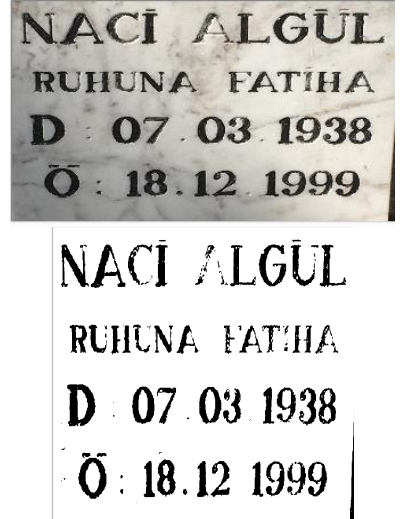
Figure 5. Pre-processed image for text extraction